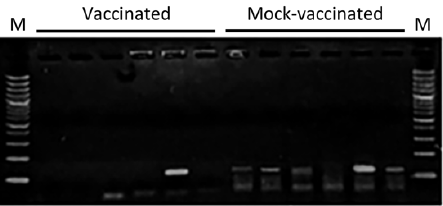
Figure 4. Detection of viral transcripts in caudal fin samples of gilthead seabream 10 days after LCDV-Sa challenge in vaccinated fish (injected with pcDNA-MCP) and mock-vaccinated fish (injected with pcDNA) at 21 days post-vaccination. M, molecular weight marker (100 bp DNA ladder).